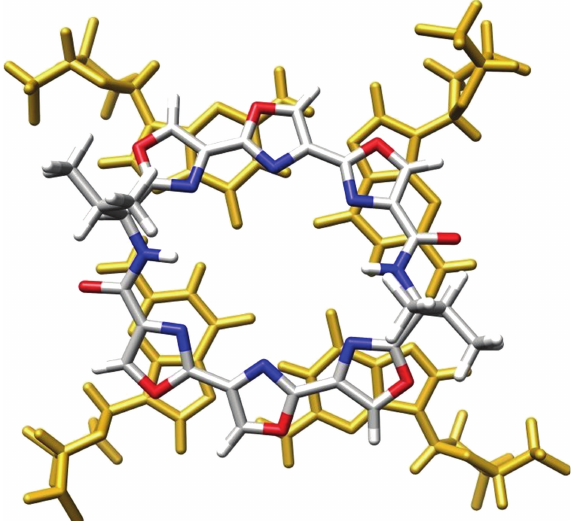
Figure 6: Interaction of TMPyP4 and a G-tetrad (adapted from PDB entry: 2A5R); guanine residues appear in gold; the carbon, nitrogen, oxygen, and hydrogen atoms of TMPyP4 appear in grey, blue, red, and white,